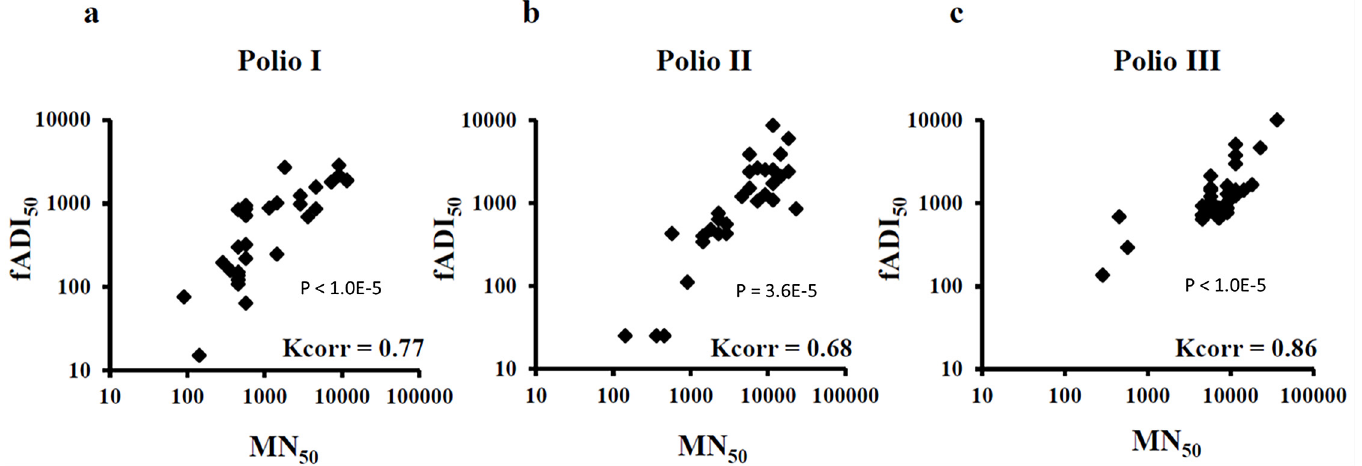
Fig 5. Correlation between fADI and MN methods for Polio I, II and III. fADI 50 were calculated from the Virus Attachment Indexes using a mathematical approximation model (see text for details). fADI showed a significant correlation of virus attachment blocking for polioviruses of serotypes I, II and III with the data of microneutralization assay obtained independently at CBER/FDA using the WHO miconeutralization protocol.